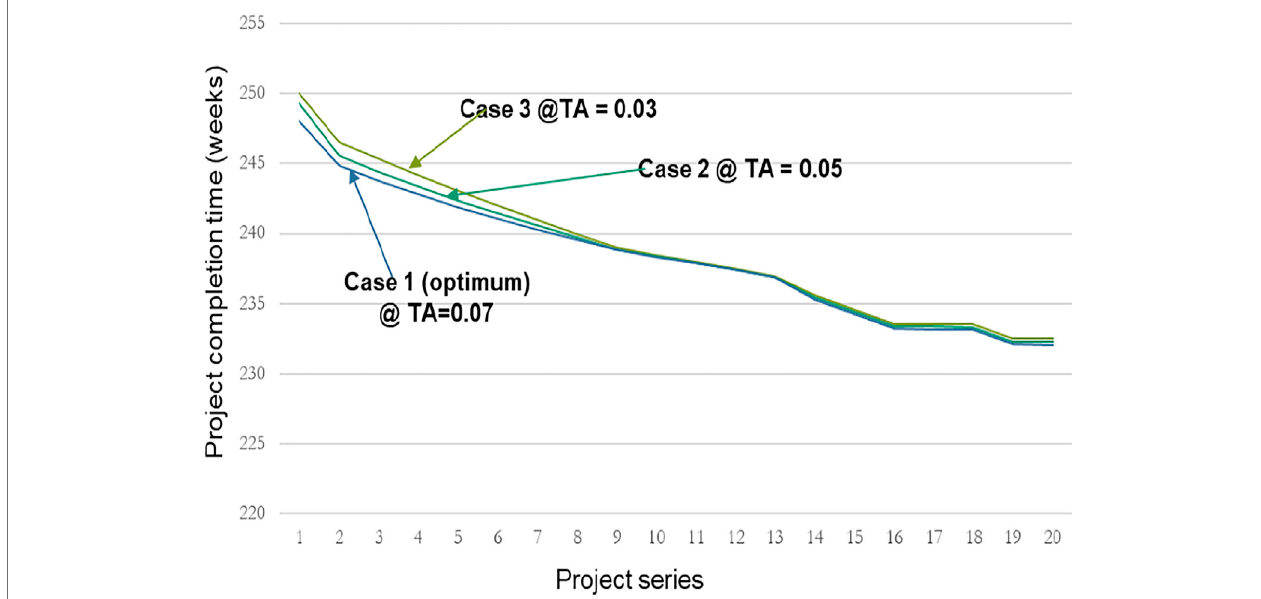
FIGURE 7 | Impact of technology on the project completion time of different project series.